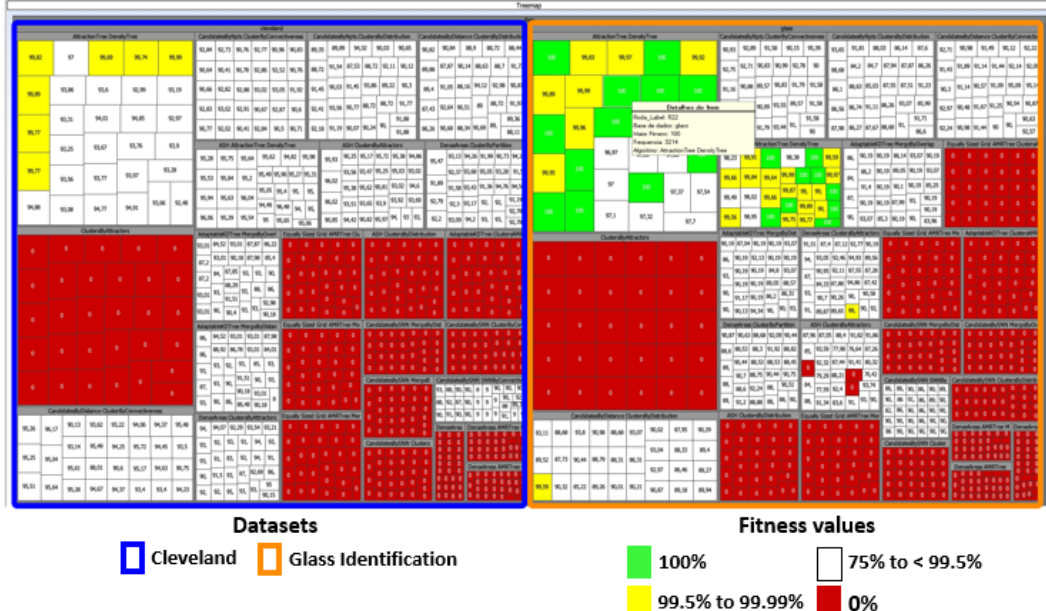
Figure 10. Treemap with the organization of fitness throughout the generations for the Cleveland Heart Diseases and Glass Identification